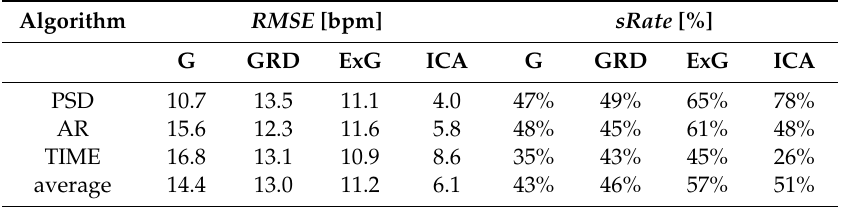
Table 3. The median sRate and RMSE for selected algorithms and signal extraction